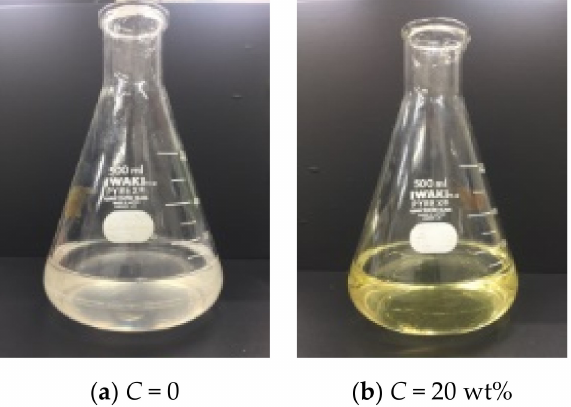
Figure 7. Photo of filtrate ( s c = 0.078, p = 50 kPa): ( a ) C = 0; ( b ) C = 20 wt%.